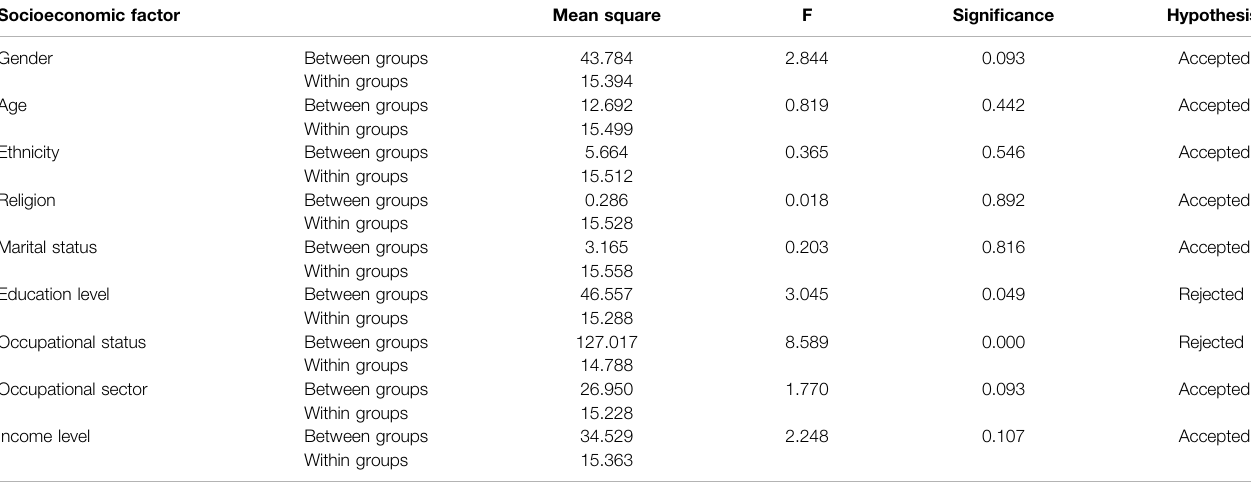
TABLE 7 | ANOVA of home – public transportation station distance with sociodemographic background. Socioeconomic factor